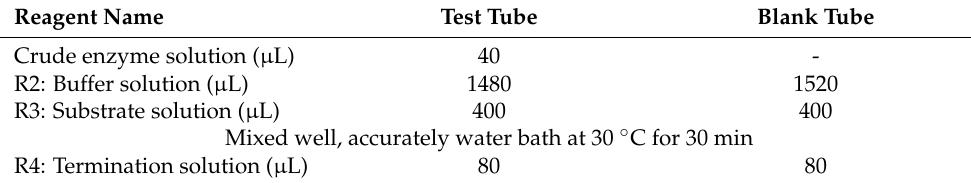
Table 3. Operation